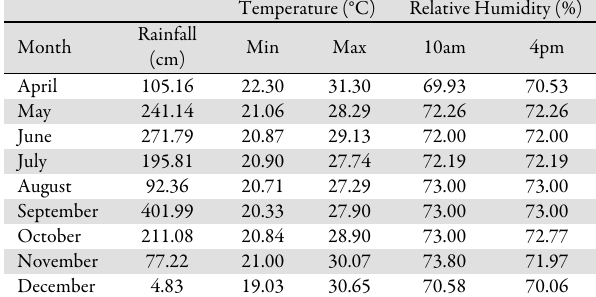
Table 2. Mean monthly rainfall (mm), temperature (°C) and relative humidity (%) during the early and late season planting